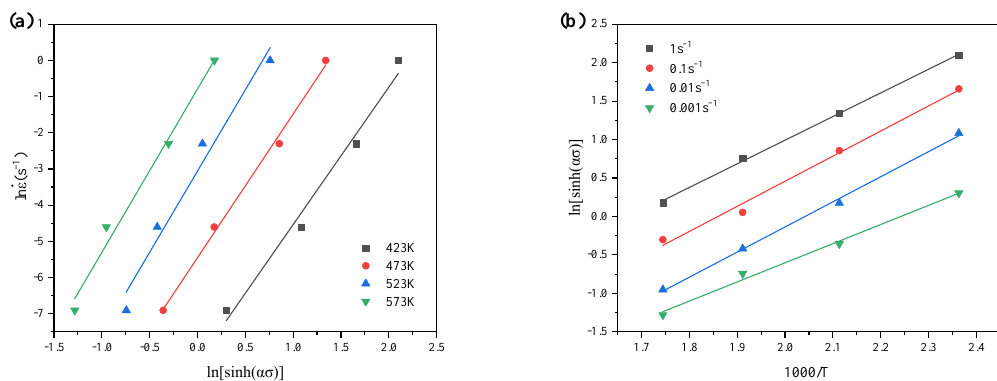
. ε ; ( b ) 1000/T~ln[sinh( ασ ; ( b ) 1000/T~ln[sinh( ασ )]. 𝜀𝜀̇